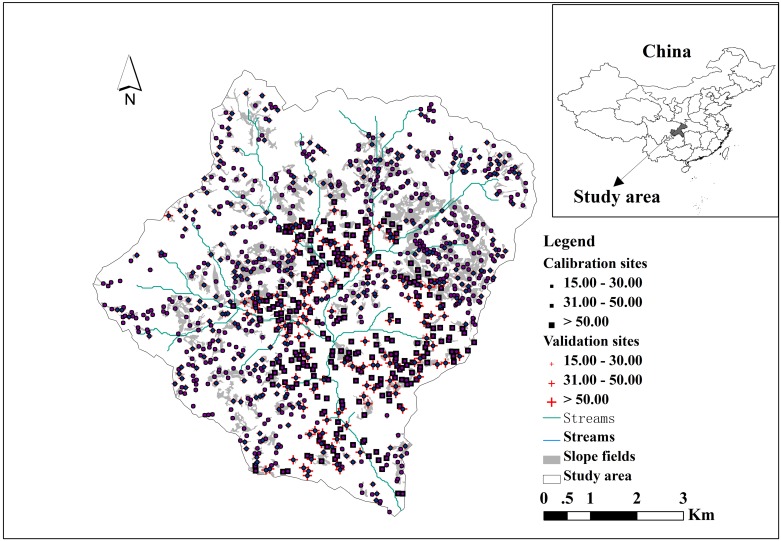
Maps of the watershed location and soil sampling sites.